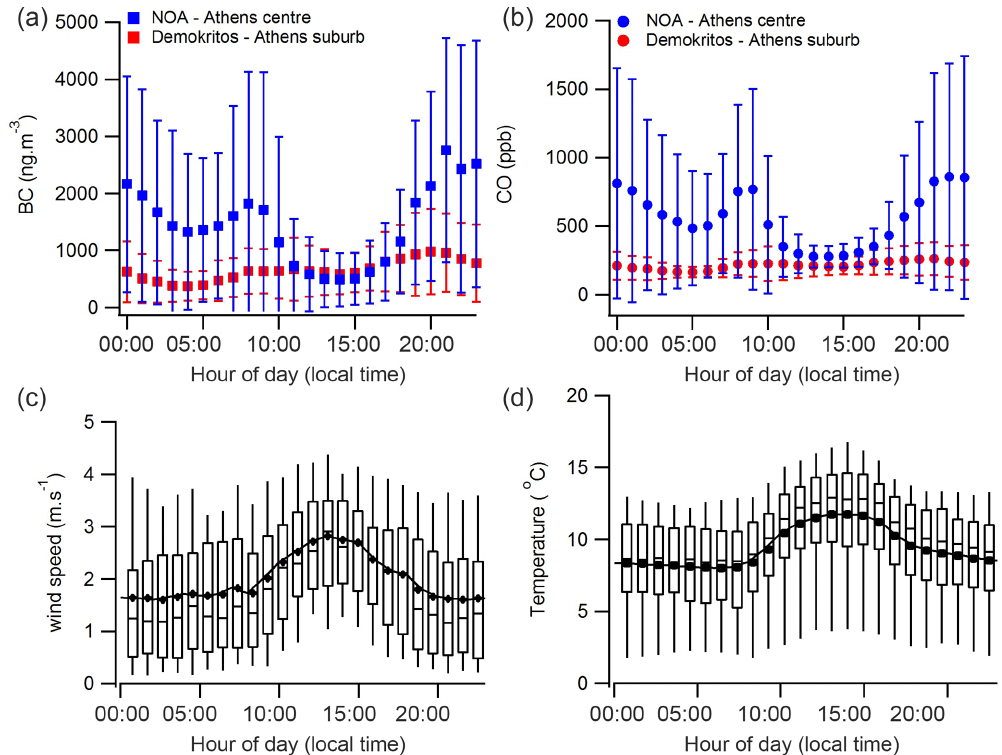
Figure 4. (a, b) Diurnal trends of BC (a) and CO (b) concentrations at NOA (blue) and DEM (red) monitoring stations (local time = UTC). Vertical bars show standard deviation to the mean value. Diurnal trends of wind speed (c) and temperature (d) measured at the meteorological station of Demokritos. Data are presented as box and whisker plots, where boxes encompass values between the 25th and 75th percentiles, horizontal lines represent median values, and “whiskers” give the 80% range of the values, whereas markers represent the mean values. Table 2. BC / CO (ngCm − 3 ppbv − 1 ) ratios derived from emission factors found in the literature and from ambient measurements in Athens using the multiple regression